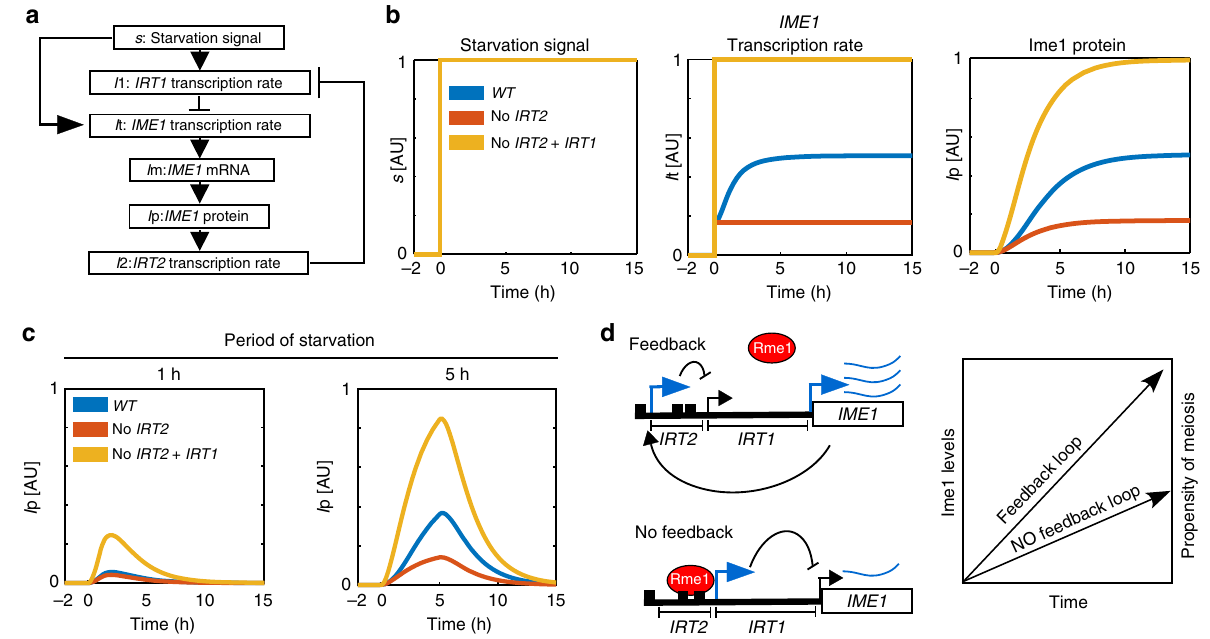
Fig. 7 Model for the regulatory circuit consisting of IME1 and the lncRNAs, IRT2 , and IRT1 . a Model for Ime1 regulation by IRT1 , IRT2 , and IME1 (see Supplemental information for details). All the variables and connections between variables are displayed. b Simulation of IME1 transcription rate ( I t) and Ime1 protein accumulation ( I p) prior ( s = 0, before 0 h) and during starvation ( s = 1) for the wild-type IME1 promoter, in the absence of IRT2 (no IRT2 ), or in the absence of IRT1 and IRT2 (no IRT2 + IRT1 ). The y axis displays the level of s , I t, or I p in arbitrary units (AU) scaled between 0 and 1. c Similar as b except that Ime1 protein accumulation ( I p) was simulated during starvation periods of 1 h and 5 h, respectively. d Model of feedback cascade involving IME1 , IRT2 , and IRT1 . In the presence of the regulatory circuit consisting of IME1 , IRT2 , and IRT1 , Ime1 is able to stimulate its own expression. This increases the propensity for cells to undergo meiosis. Cells lacking the feedback signals from Ime1 to IRT2 and IRT1 show reduced IME1 expression and have a lower ability to enter